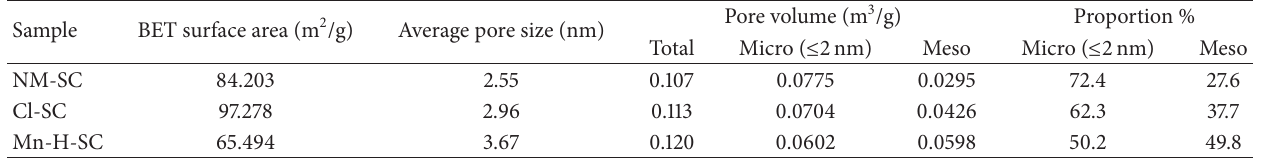
Table 1: The BET surface area and pore parameters of